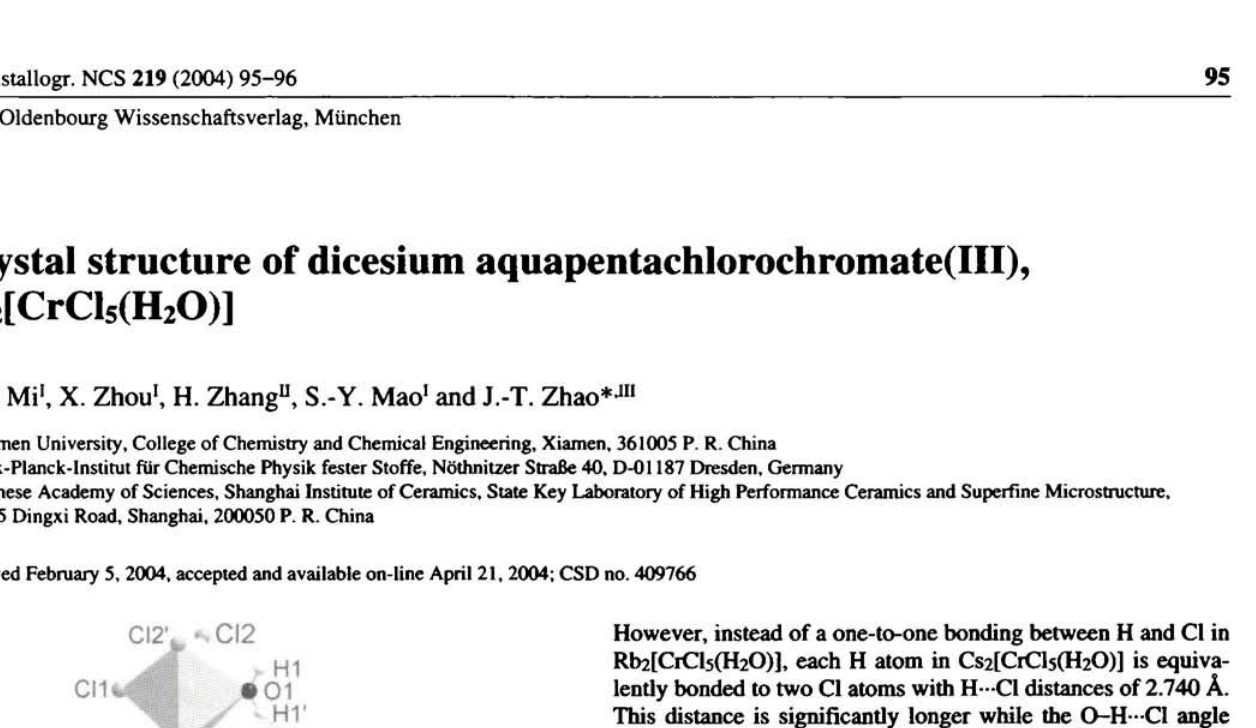
Table 1. Data collection and handling.